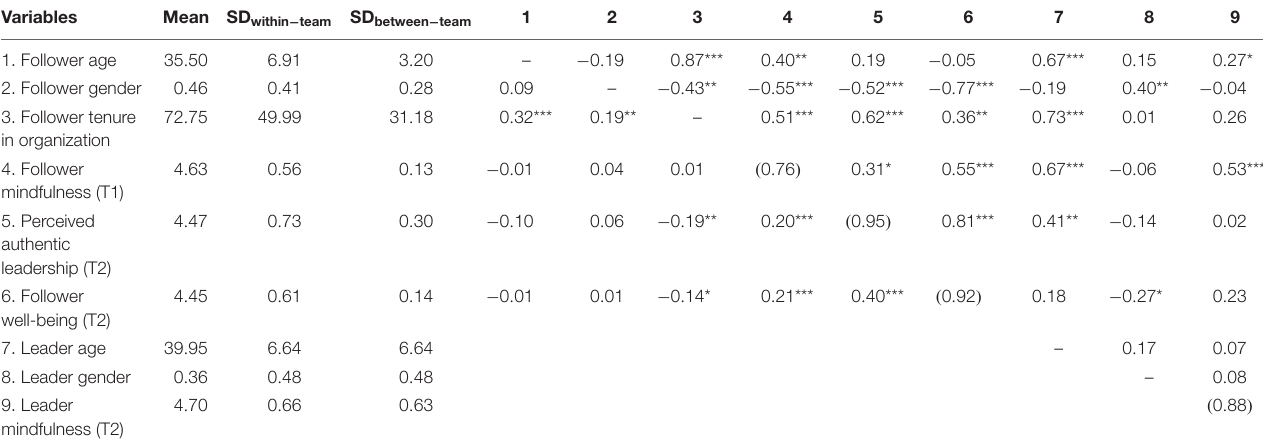
TABLE 1 | Means, standard deviations, and correlations among variables. Variables